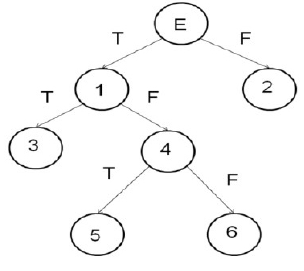
Figure 3. Sample